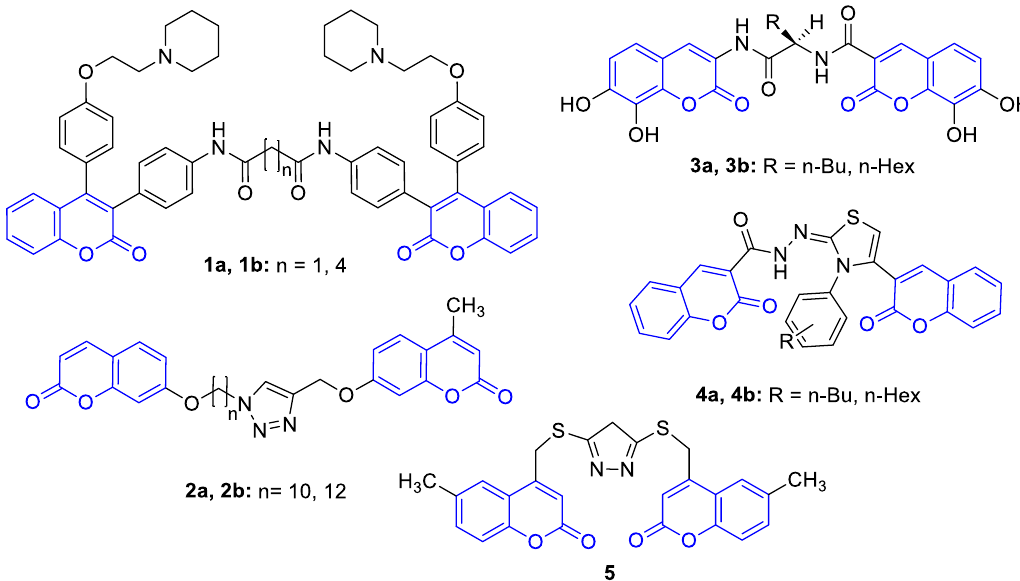
Figure 1. Chemical structure of selected multi-anticancer-directed ligands 1 – 5 bearing a coumarin moiety.